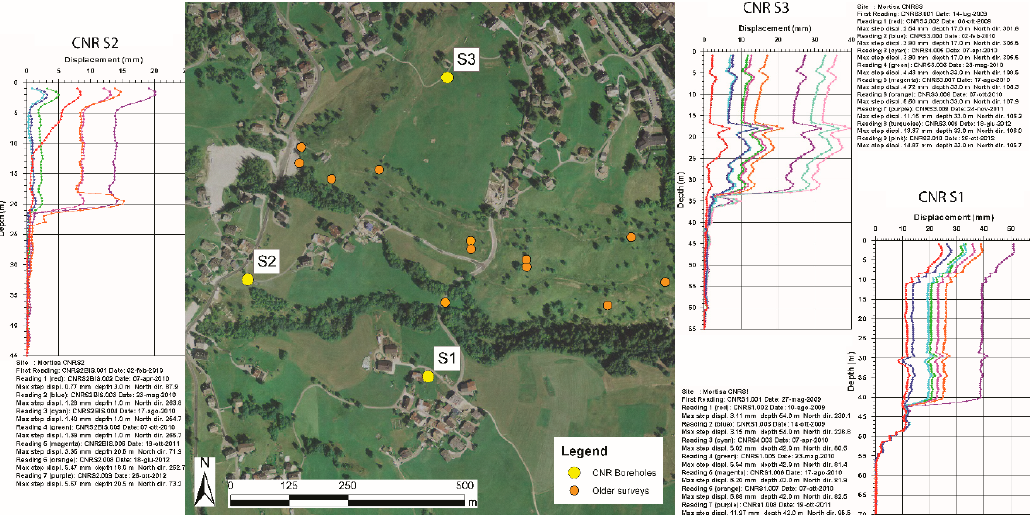
Figure 3. Location of the three new inclinometers placed by CNR-IRPI in comparison with the location of the ones of the 1989–1991 campaign. Vertical reads on the three instruments.